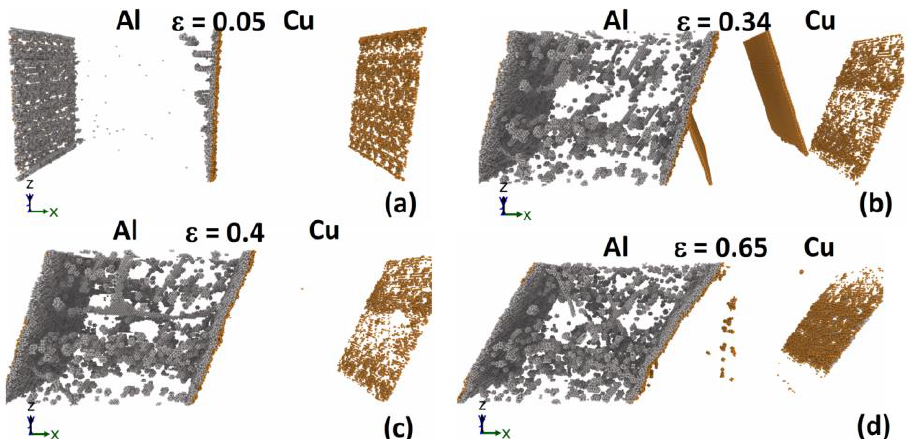
Figure 19. Development of plastic deformation in Al-Cu composite with the (110)+misorientation interface at the initial pressure of 0 GPa: ( a ) Plasticity initiation in Al; ( b ) penetration of plasticity into Cu part; ( c ) generation of secondary dislocations and vacancies in Al; ( d ) absorption of stacking faults in Cu by the interface. The misorientation angle is 12.1 ◦ .